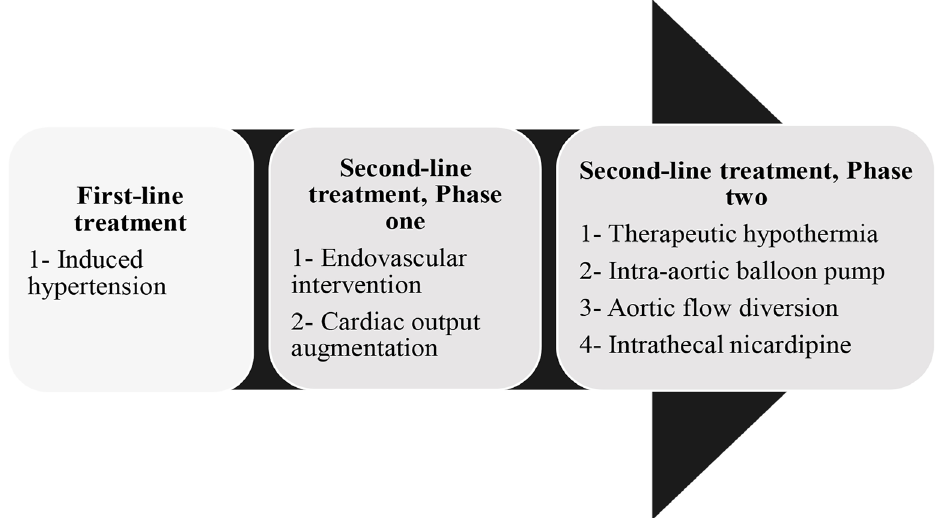
Figure 1. DCI treatment after